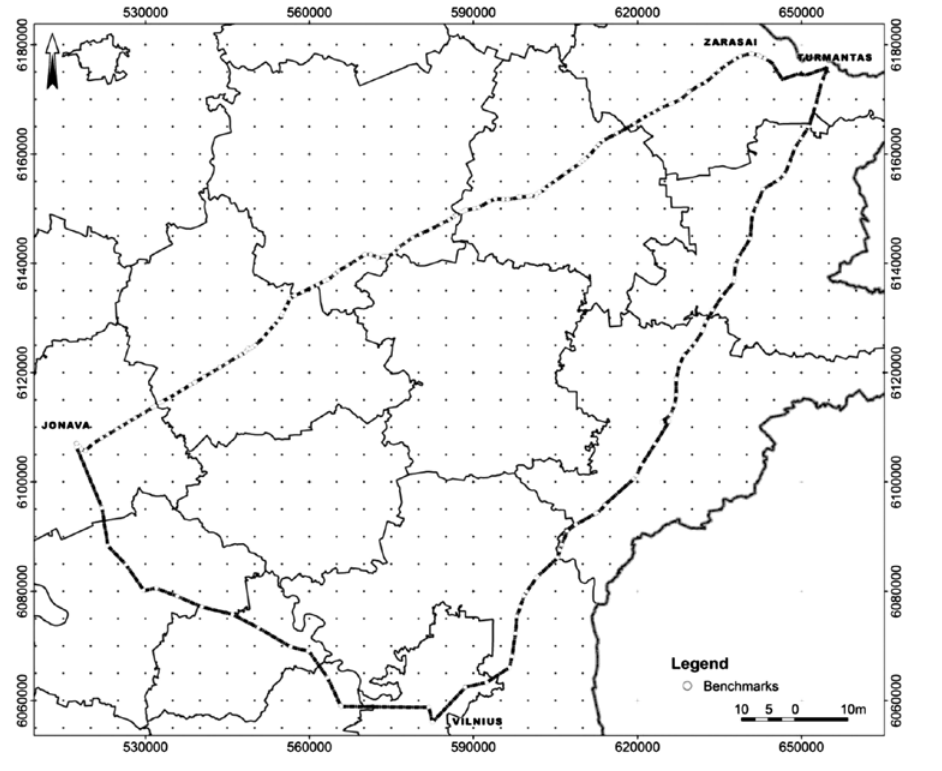
Fig. 2. In Vilnius–Jonava–Zarasai–Turmantas–Vilnius polygon, points are spread using a 5´5 km pattern. At these point values of vertical movement of the earth’s crust velocities were predicted